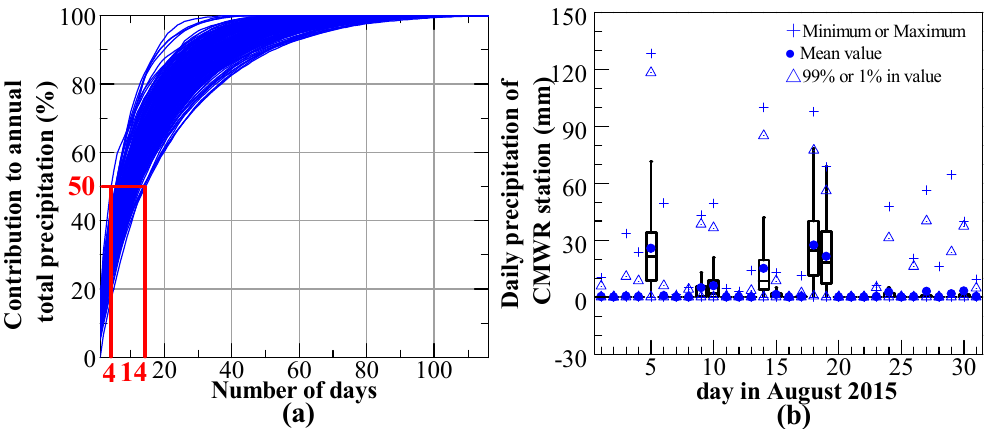
Figure 2. ( a ) Contribution (%) of the accumulated daily precipitation to the annual total precipitation for each precipitation station in the WJB watershed in 2015; the data were provided by the China Ministry of Water Resources (CMWR); ( b ) box plot * of daily precipitation from the 215 CMWR precipitation stations. * The lower and upper edges of the central box represent the first and third quartiles (25% and 75%, respectively), and the band inside the box represents